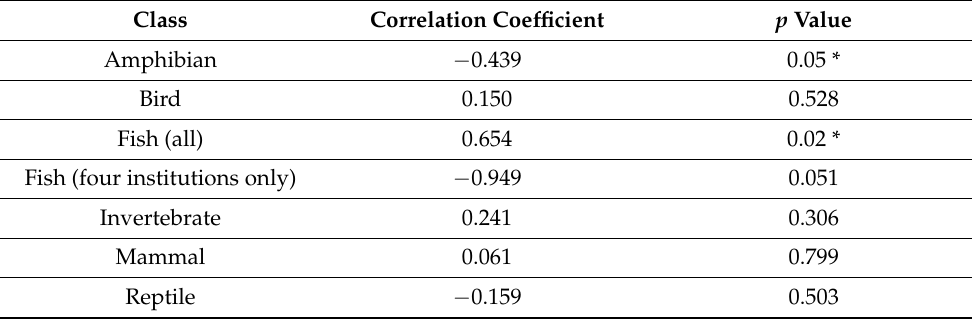
Table 3. Taxonomic proportion in posts, Spearman’s rho correlation coefficients and p values that compare the proportion of each taxa held across zoos and the number of posts on that taxonomic class.